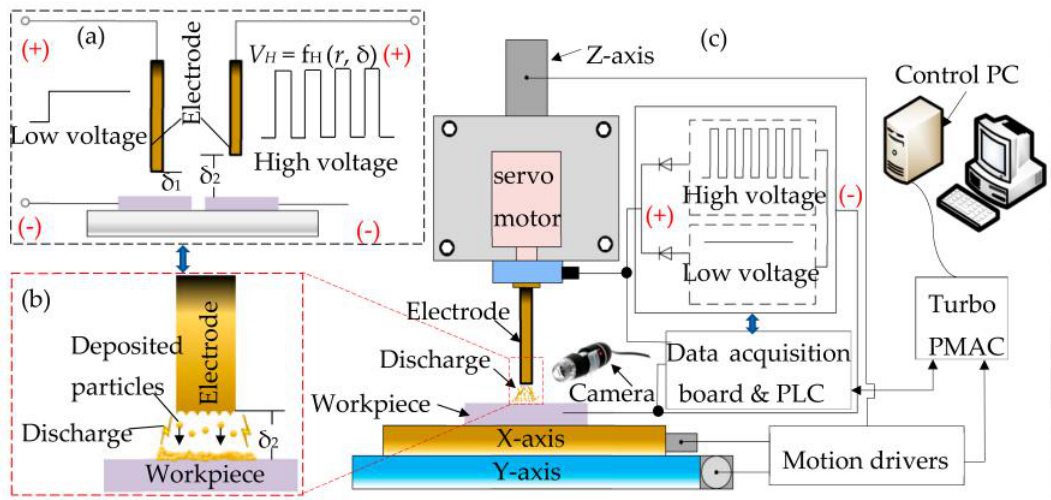
Figure 1. Schematic of discharge principle and device ( a ) the gaps of breakdown at di ff erent voltages (where V H is high voltage and r is the radius of electrode), ( b ) microcosmic diagram of deposition process and ( c ) the illustration of HV- µ